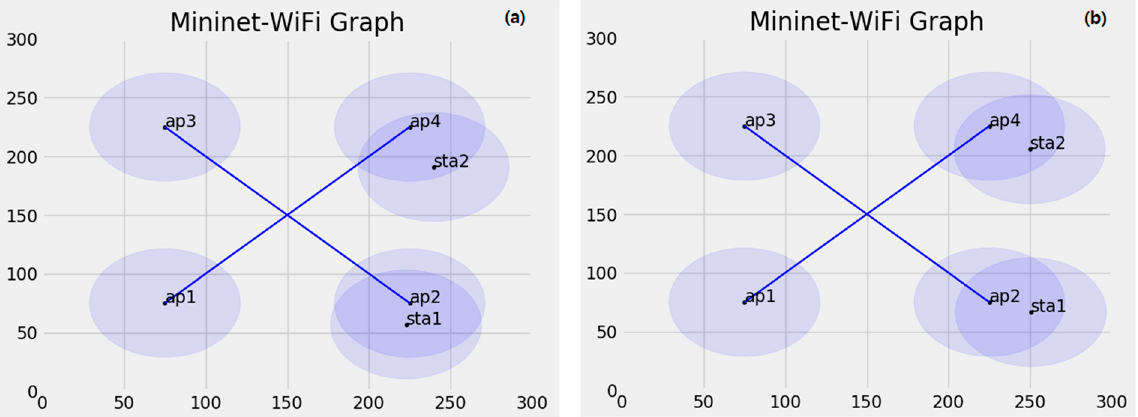
Figure 7. Simulation of SDN network along with mobility. ( a ) mobility frequency 0.25 and ( b ) mobility frequency 0.50.